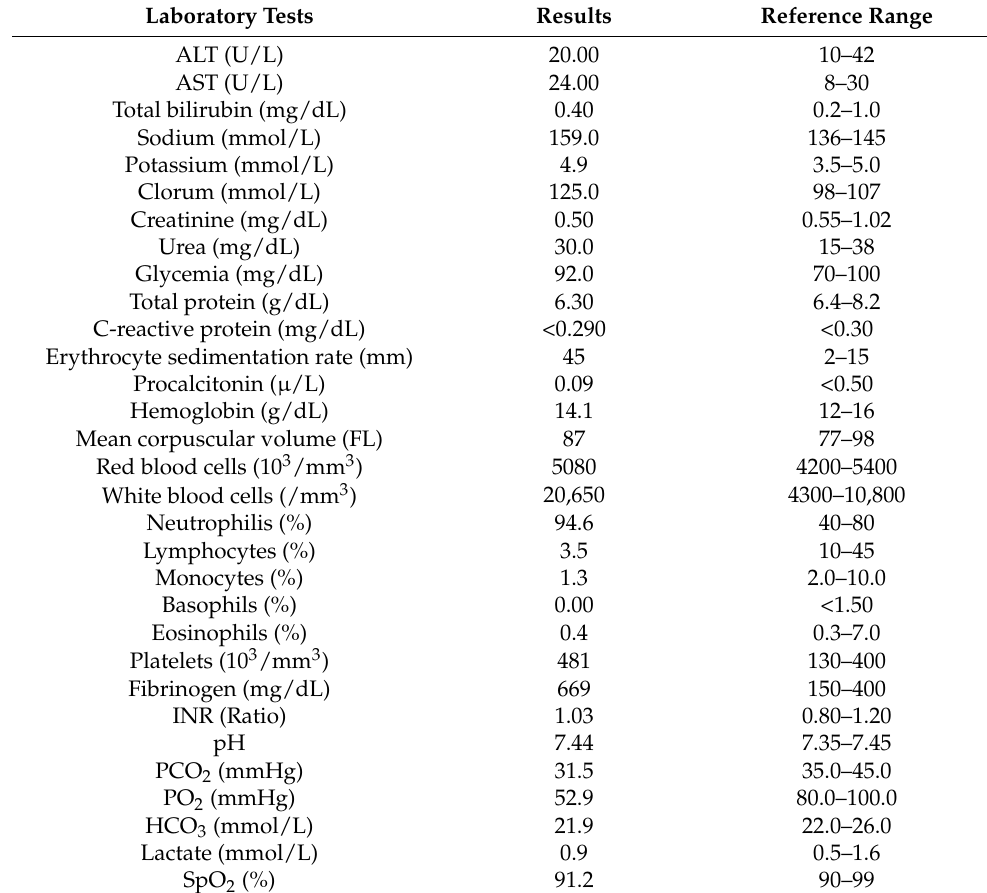
Table 1. Results of laboratory tests and blood gas